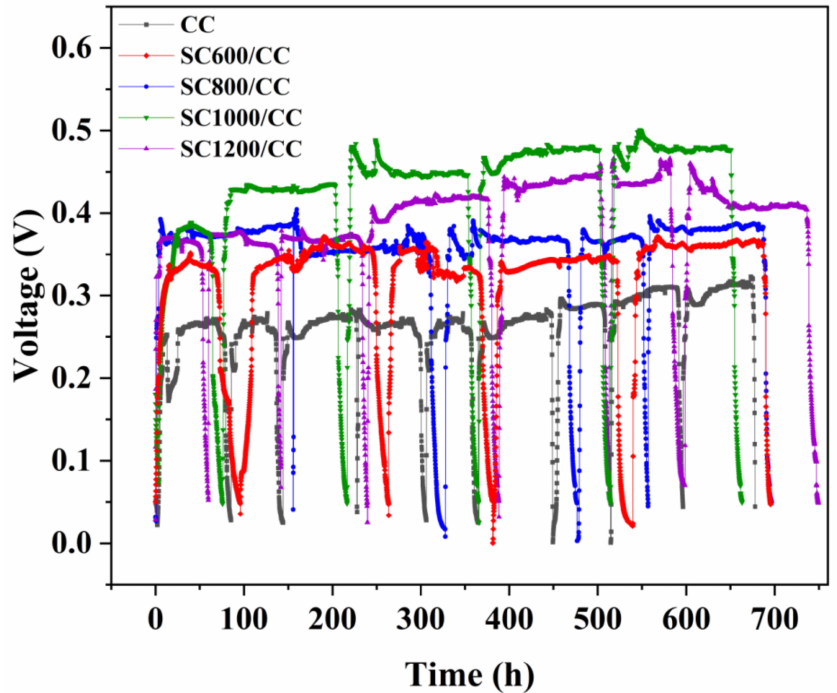
Figure 7. Reproducible cycles of output voltages produced in MFCs equipped with different